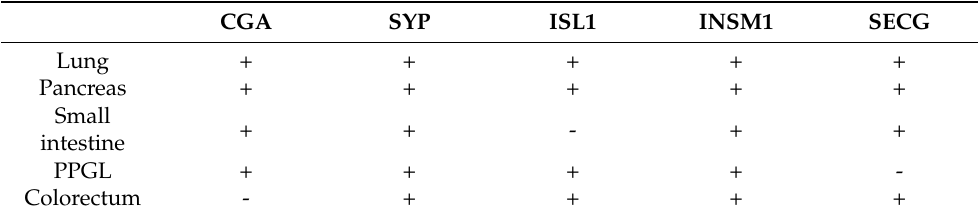
Table 1. Schematic overview of tissue-specific expression patterns in NET for first- and second- generation neuroendocrine